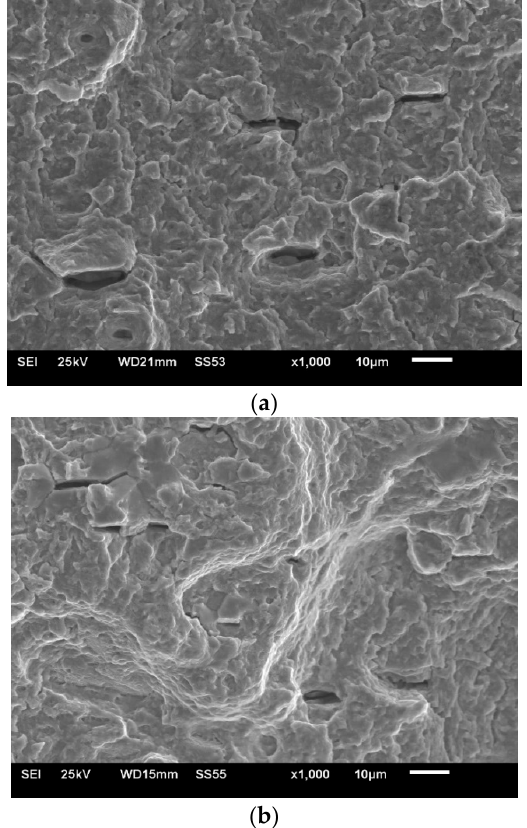
Figure 14. Typical Fatigue Fracture Surface Features Present in the Austempered 4140 Samples at high ∆ K Values. ( ∆ K = 50 MPa √ m; crack growth direction was from top to bottom of photos). ( a ) Uncharged (No Hydrogen); ( b ) Hydrogen-Charged.